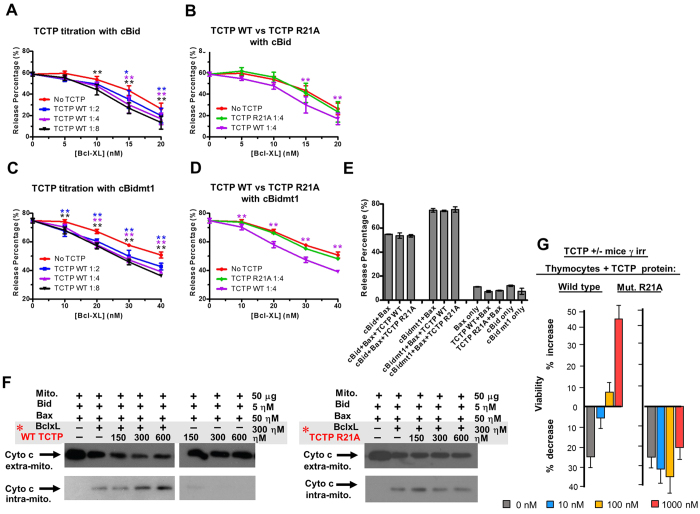
TCTP potentiates Bcl-xL inhibition of Bid/Bax.(A–E) in vitro reconstitution assay on liposome permeabilization. Increasing concentrations of Bcl-xL were incubated in different molecular ratios [Bcl-xL:TCTP] with TCTP WT (A,C) or with a fixed amount of TCTP R21A (B,D) at pH 9 for 45 min at 37 °C, as specified. The treated Bcl-xL was then added to reactions containing ANTS-DPX liposomes, 100 nM Bax and 20 nM of either cBid (A,B) or cBidmt1(C,D) at pH 7. Liposome permeabilization was quantified by fluorescence after 5h incubation at 37 °C where 100% release was defined as the fluorescence change due to lipid solubilization with 1% Triton X-100. Control reactions demonstrating that TCTP had no measureable effect on the function of any of the proteins other than Bcl-xL contained 320 nM pH9 treated TCTP ANTS/DPX liposomes, 100 nM Bax and 20 nM of cBid or cBidmt1 as indicated (E). Error bars, std. dev. n = 3. To compare between the TCTP treated groups and the Control group statistically, two-way ANOVA test was performed for (A–D) and one-way ANOVA test was performed for (E). Dunnett’s multiple comparisons test was used to calculate the significance of difference between the TCTP treated groups and the corresponding control group (No TCTP for (A–D), cBid+Bax or cBidmt1+Bax for E). Colored asterisks above each data point indicate the statistical significance (*p < 0.05; **p < 0.01, no asterisks if p ≥ 0.05). A complete statistical analysis is provided in Supplementary Table 2–4. (F) Permeabilization assays of mitochondrial membrane by tBid and Bax assessing cytochrome c release. Sub-optimal amounts of Bcl-xL were added as to inhibit only partially Bax mediated cytochrome c release. Bcl-xL and variants of TCTP were pre-incubated (TCTP ranging from 1.5–6μM and 3 μΜ Bcl-xL framed in gray with red asterisk to highlight the pre-incubation), pH 9, 30 °C then added to the mitochondria at the concentration displayed in the figure. Cyto c intra-mito: mitochondrial fraction. Cyto c extra-mito: in the supernatant, analysed by Western blot. Similar conditions were used for mutant TCTP R21A protein. (G) Rescue of TCTP+/− haploinsufficiency: Thymocytes from TCTP+/− mice were γ-irradiated (γ-irr) (2.5 Gy) and cultured with WT TCTP protein or mutant R21A TCTP at concentrations 0 to 1000 nM.